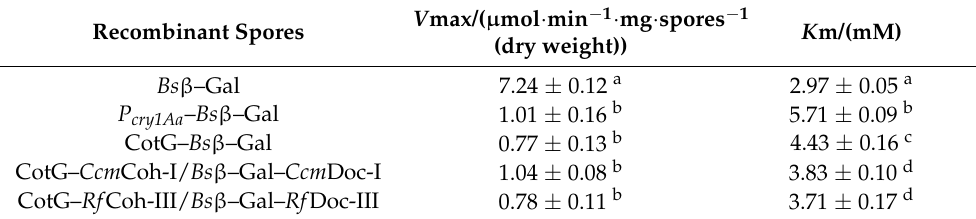
Table 3. The kinetics constants of four different types of spore displayed Bs β